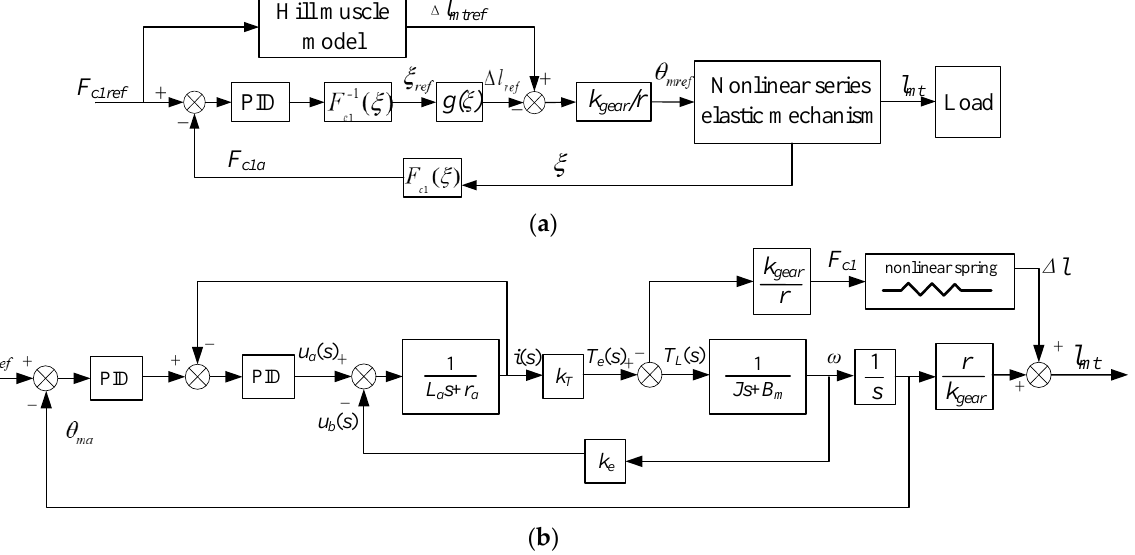
Figure 7. Block diagram of rope driver control system. ( a ) System control block diagram. ( b ) Motor closed-loop control block diagram.